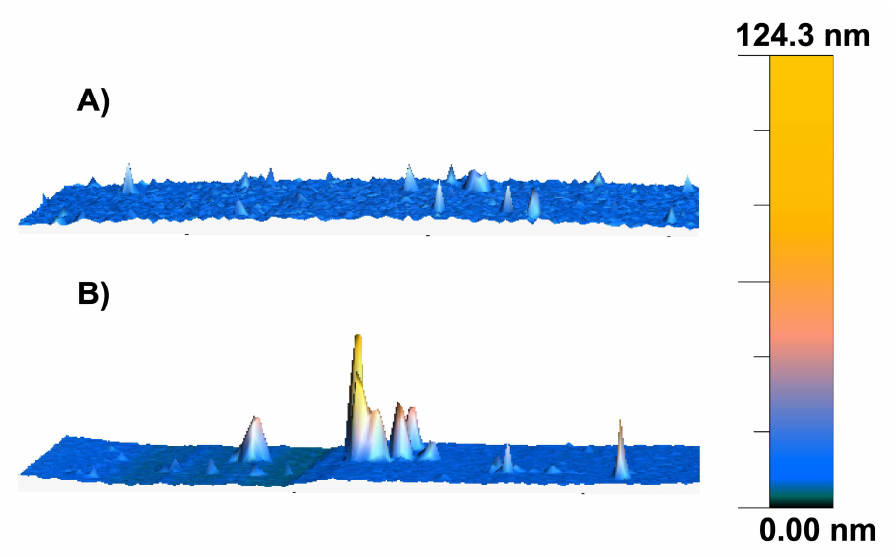
Figure 5. Surface topography of the oxytocin immobilized ACA functionalized gold surface ( A ) before and ( B ) after binding with O-NPs, mapped using AFM in non-contact mode (Image size 10 × 10 µm).